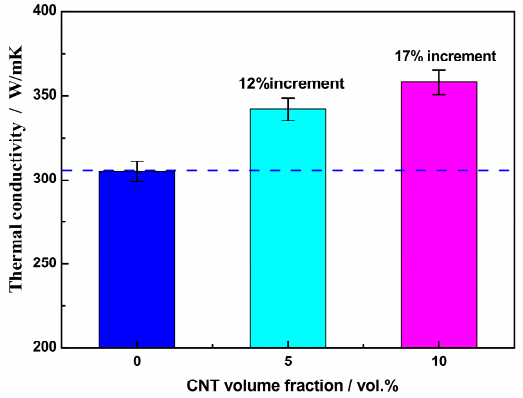
Figure 26. Thermal conductivity of CNT-(Cu-Cr) nanocomposites as a function of initial volume fraction of CNTs [150]. (Reproduced with permission from [150], Springer, 2013.)